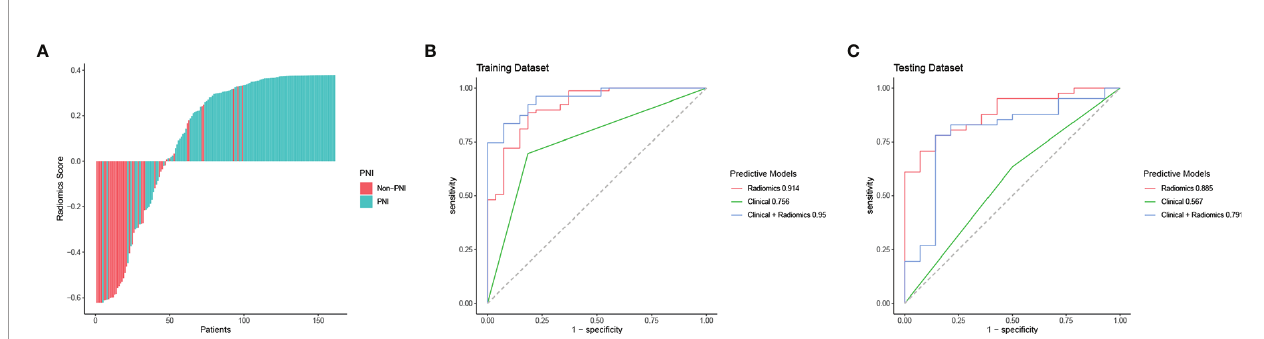
Table 2 . In addition, by using a multivariate logistic regression algorithm, the radiomics model was established based on the radiomics signature and the combined model was developed by integrating the radiomics signature and Bismuth classi fi cation.